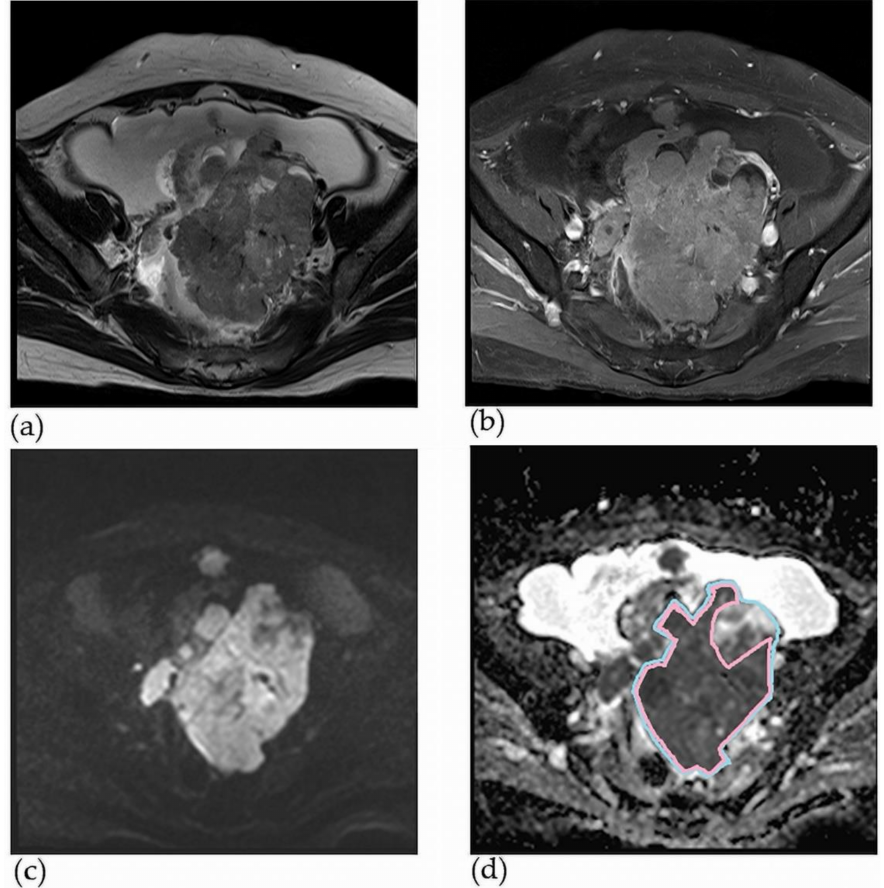
Figure 2. Method for drawing ROI in the solid portion and total ovarian lesion on the MRI of a 65-year-old woman with HGSOC (stage: IIIC), ( a ) the ovarian mass with solid portion on axial T2WI ( b ) the ovarian mass with solid portion on axial contrast-enhance T1WI, ( c ) focal increased signal intensity in the solid component of the mass on DWI (b = 1000 s/mm 2 ), ( d ) hypointense solid component on axial ADC map (the mean ADC value is 0.878 × 10 − 3 s/m 2 blue line: total ovarian lesion, pink line: solid portion). ROI: region of interest, MRI: magnetic resonance imaging, HGSOC: high-grade serous ovarian cancer, T2WI: T2-weighted image, T1WI: T1-weighted image, ADC: apparent diffusion